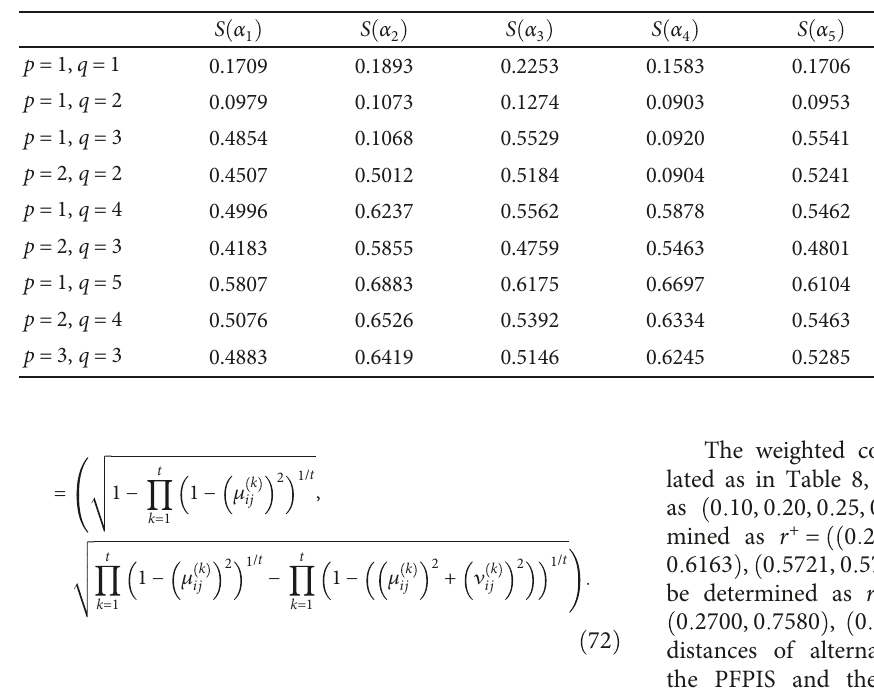
Table 9: Results of di ff erent p and q considering interaction with one